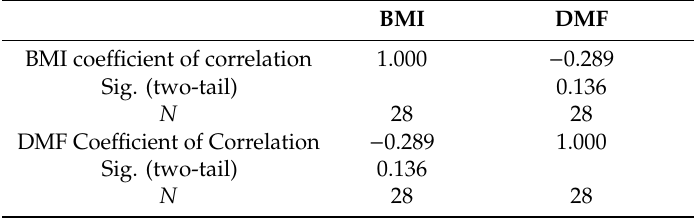
Table 10. Data related to the correlation between BMI and DMF evaluated in risk of overweight patients.